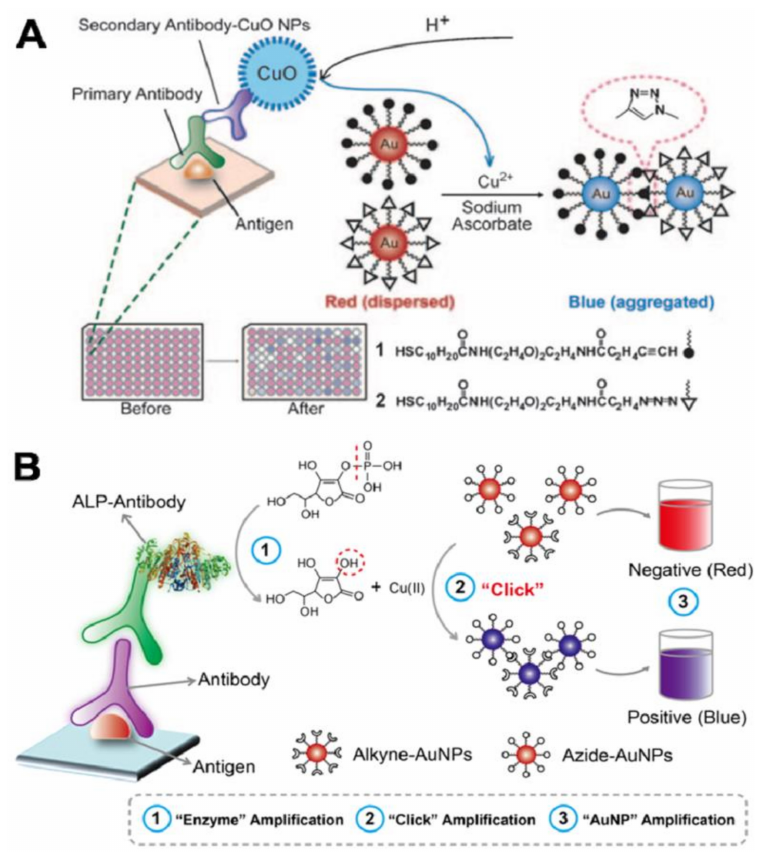
Figure 30. Surface changes in Cu-AAC immunosurveys for Au NP. ( A ) Anti-CuO and azide and alkyne-modifited au-NPs based immuno-assays. ( A ) CuO NPs have been dissolved to release copper ions, which have caused Au-via NP’s CuAAC to be aggregated. ( B ) Immuno assay between azide and alkyne-functionalized Au NPs based on ALP-triggered CuAAC. Copyright 2011, Wiley, adapted with reference permission